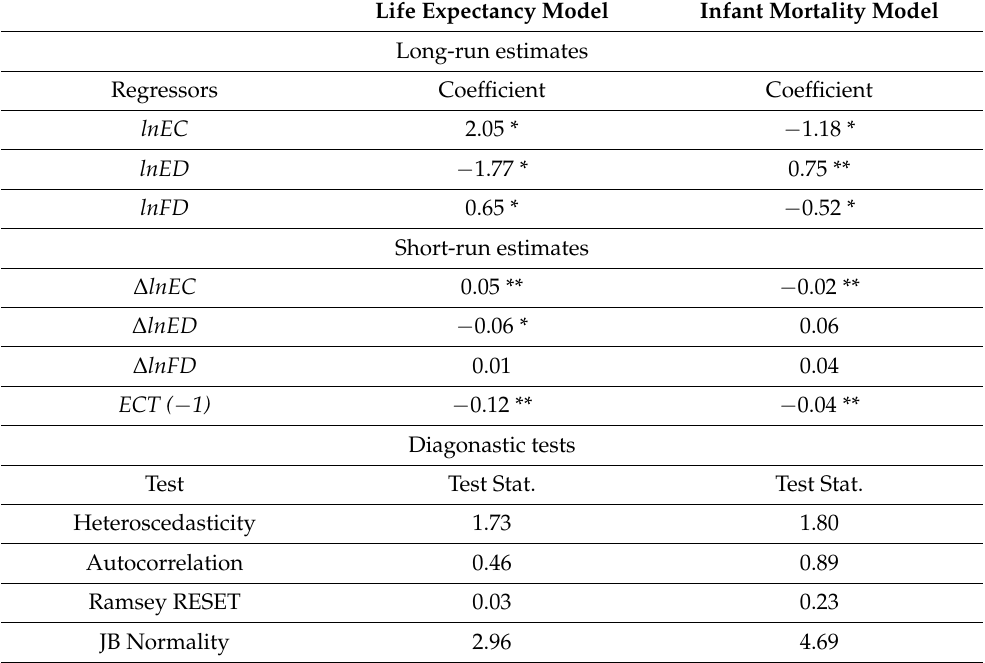
Table 12. Estimates for Health Outcome Models.